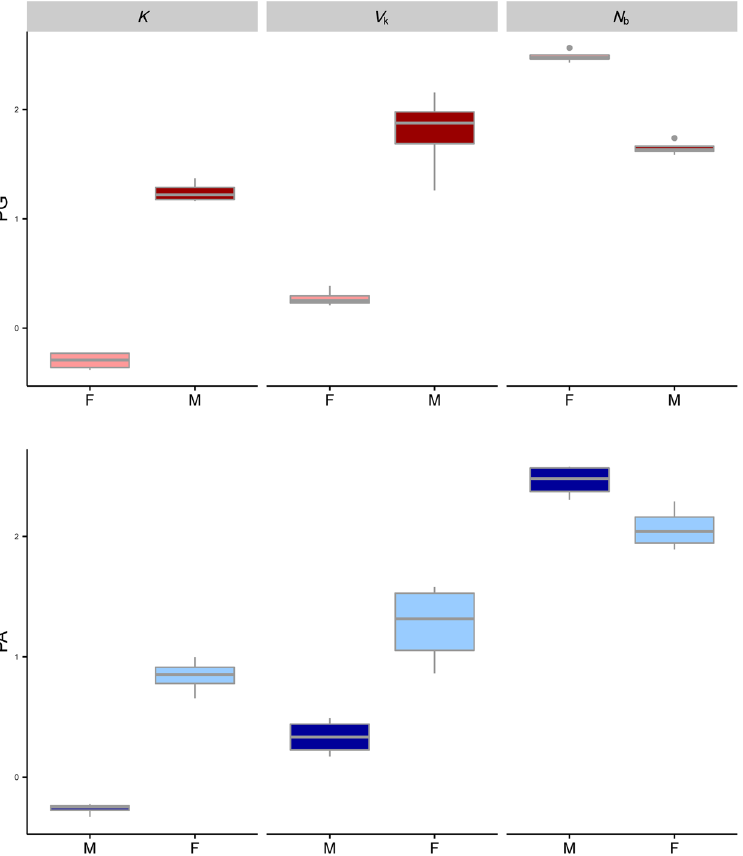
Figure 3. Graphical representation of some annual key parameter estimates (obtained with AgeNe) in each life history strategy, per sex. ¯ k : annual mean number of offspring; V k : annual variance in reproductive success; N b : annual effective number of breeders. Values are log 10 transformed to improve visualization. Protandry in blue (panel a); protogyny in red (panel b); lighter colour: females - F; darker colour: males -